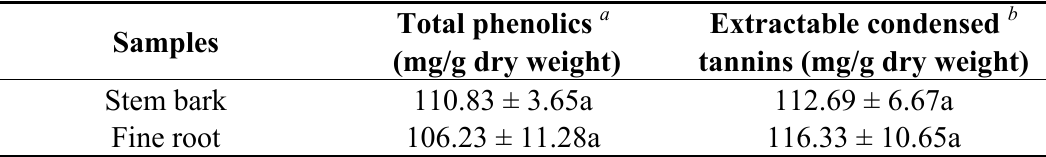
Table 1. Contents of total phenolics and extractable condensed tannins in stem bark and fine root of C. equisetifolia (n = 3).